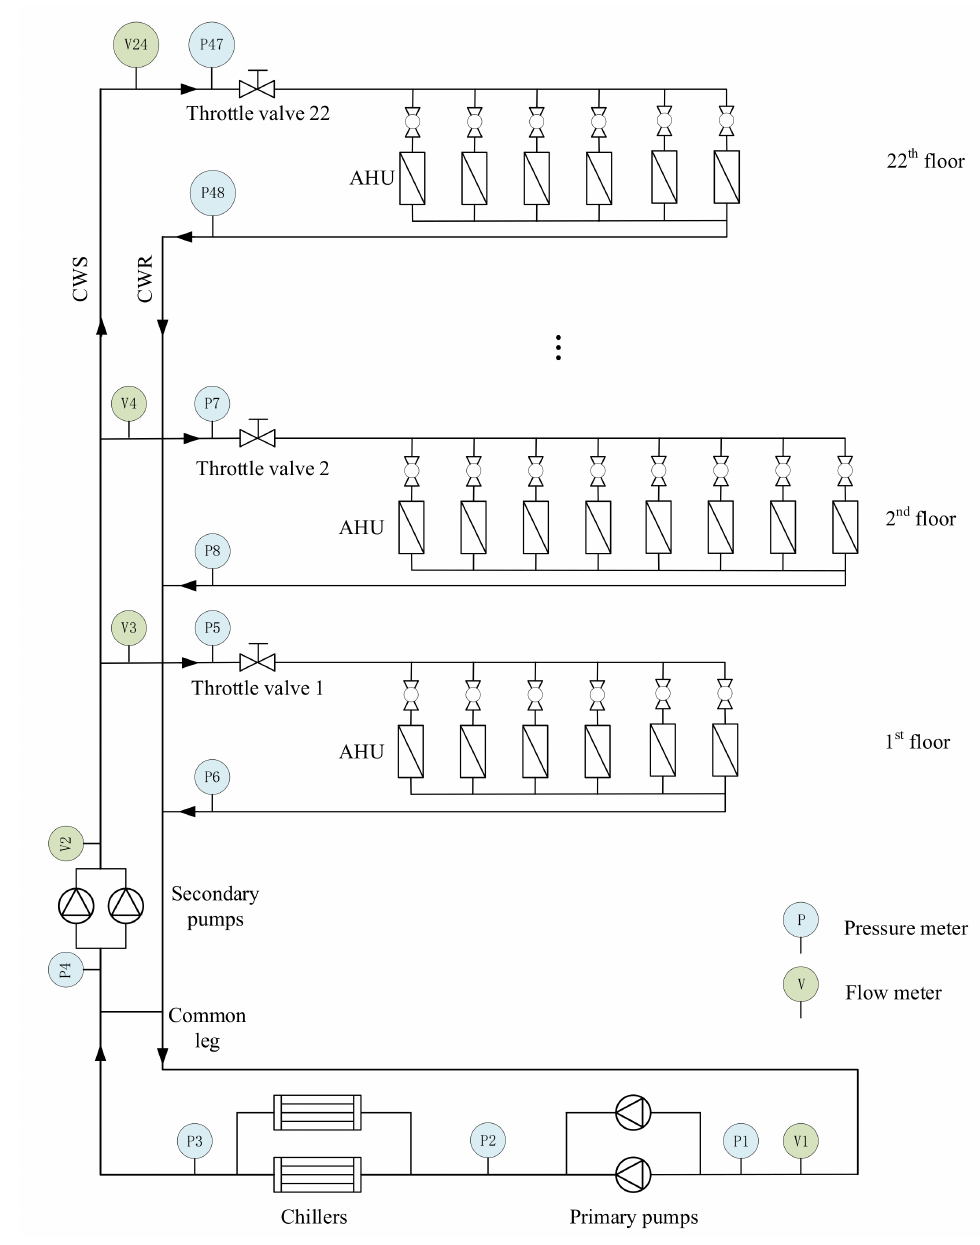
Figure 6. Topology of the chilled water distribution